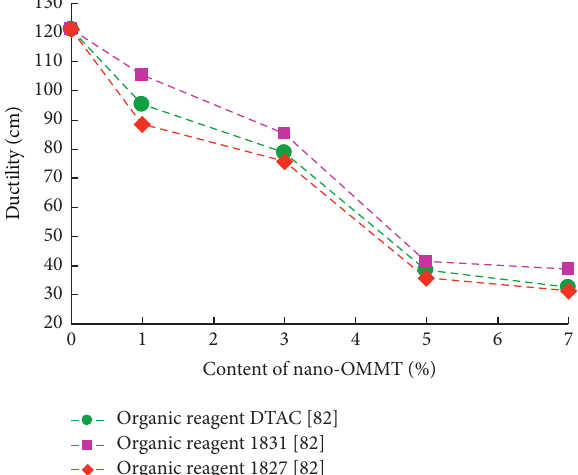
Figure 23: Organic reagent effect on softening point.